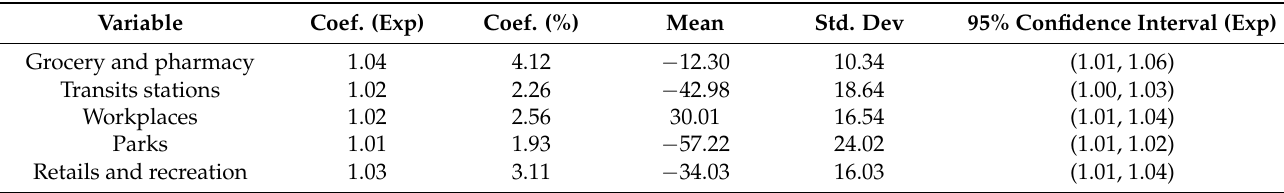
Table 5. The regression coefficient of mobility